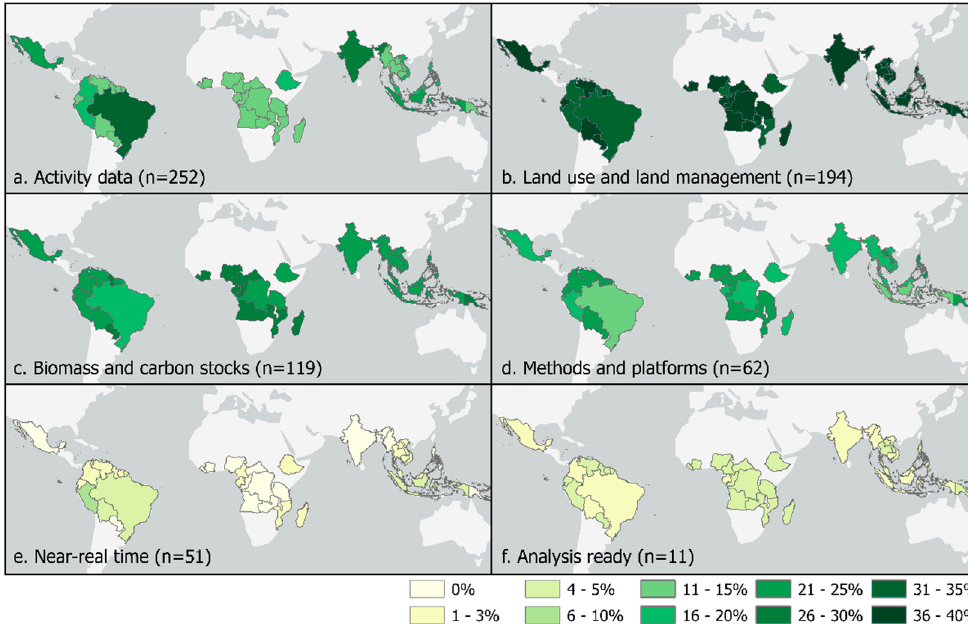
Figure 4. Classification of the countries regarding the percentage of every category of study per- formed in each country between 2018 and 2020, where n represents the number of studies in each category. The percentages for each country across all panels total 100% (e.g., Brazil: 32.5% of studies related to activity data, 31.4% to land use and land management, 18.1% to biomass and carbon stocks, 13.4% to methods and platforms, 3.1% to near-real time alerting, and 1.5% to analysis ready).